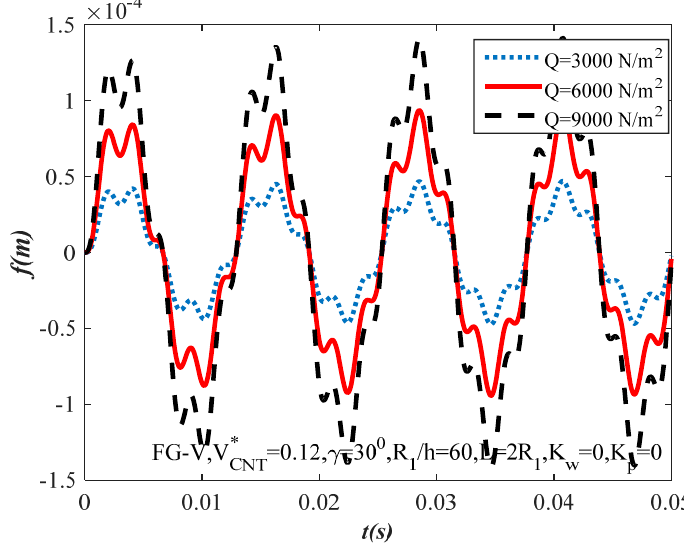
Figure 10. Effect of amplitude Q on the dynamic response of the FG-CNTRC truncated conical shells.